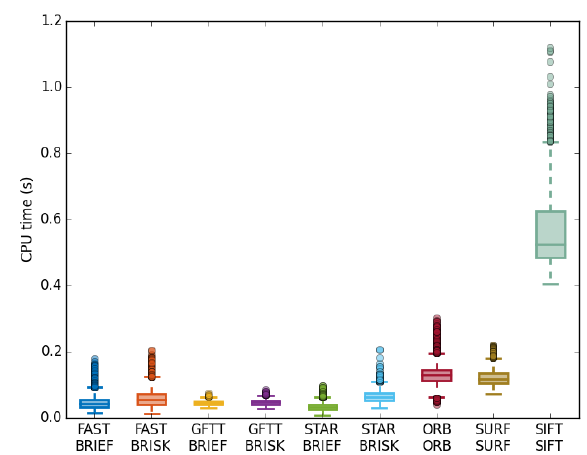
Figure 2. Total tracking time achieved by each con-